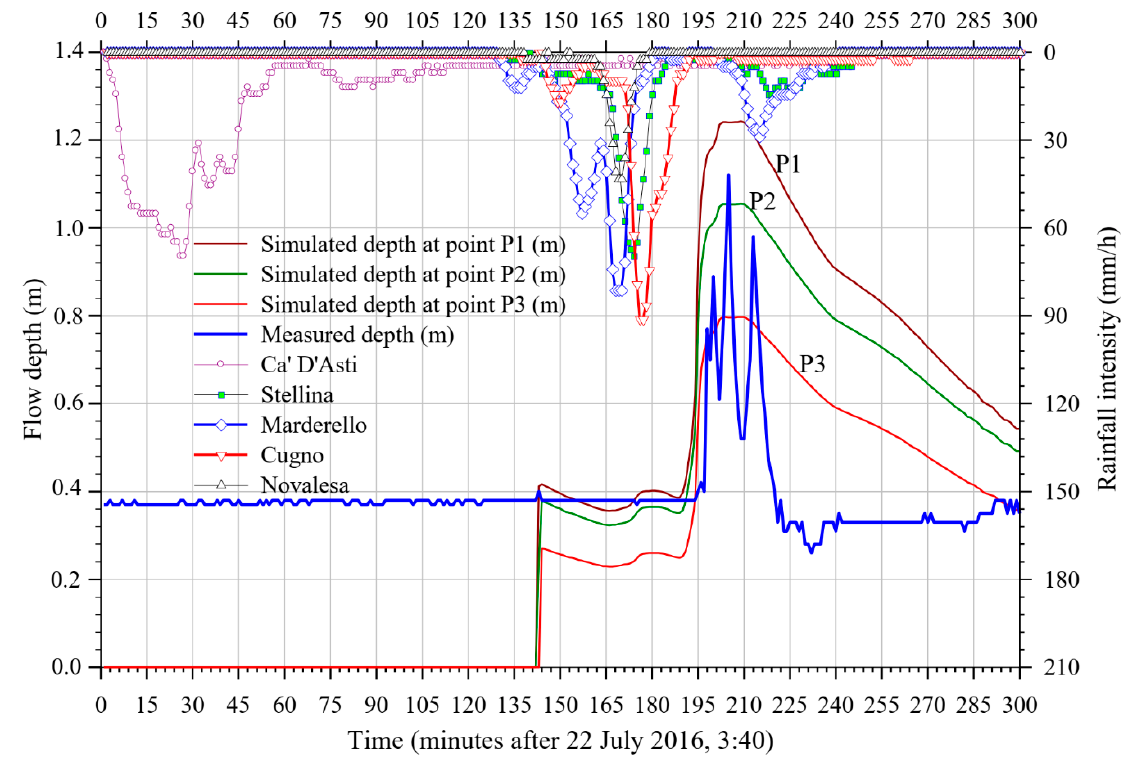
Figure 8. Simulation S28; comparison among the flow depth curves resulting at the 3 selected ‘numerical stations’ (P1, P2, P3) and the data measured at pluviometric and hydrometric stations.